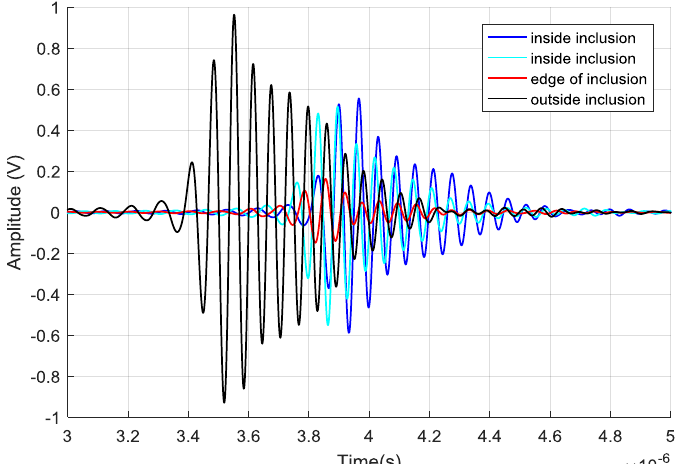
Figure 2. Raw data of the received signal as a function of time in different places of the phantom: outside (black line), inside (light blue and blue lines) the agar inclusion of 12 mm in diameter and at the edge of it (red line).